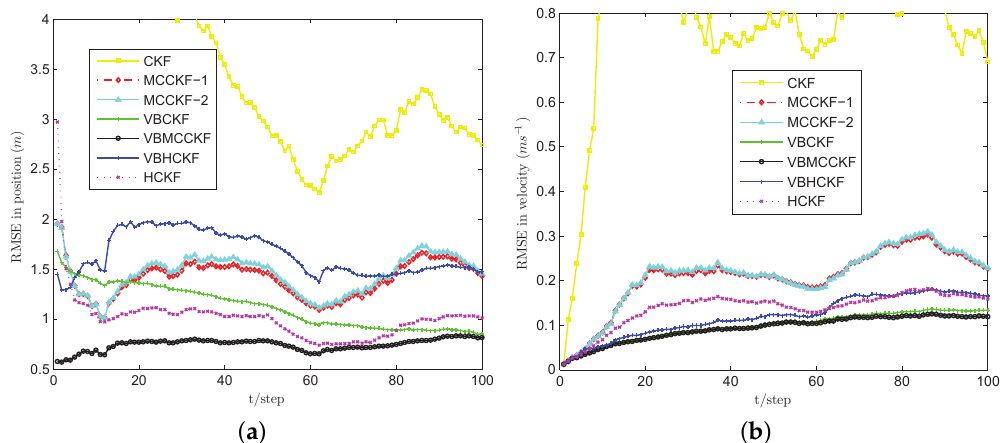
Figure 5. RMSE performances of different filters under Case D. ( a ) position; ( b ) velocity.